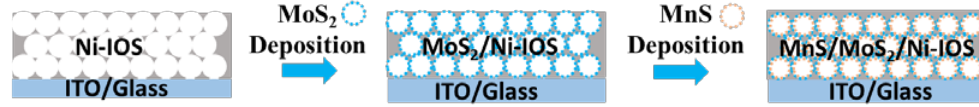
Figure 1. Schematic diagram of the experimental setup for the electrophoretic self-assembly (EPSA) method.